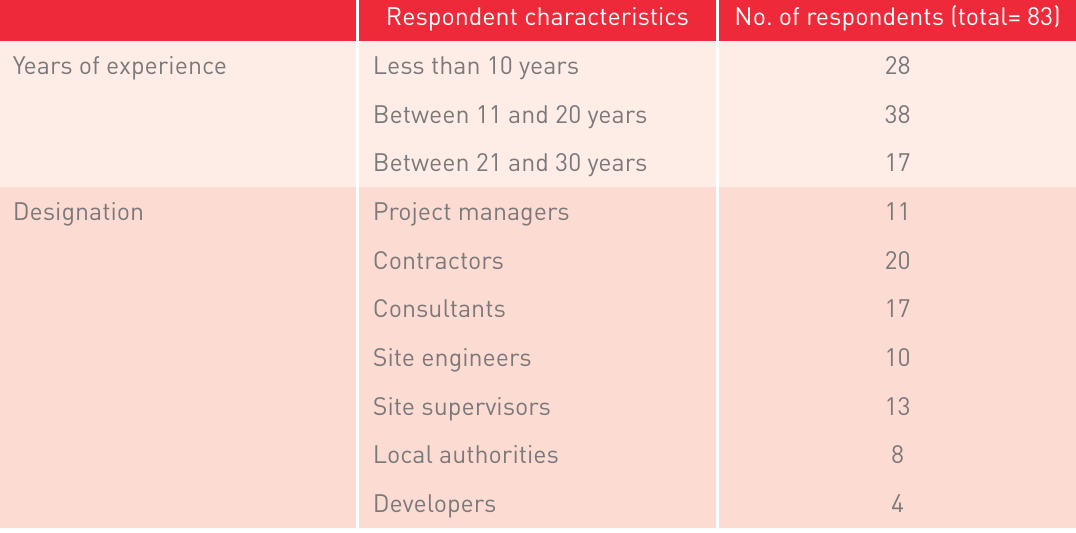
Table 1. Demographic profile of respondents Respondent characteristics No. of respondents (total= 83) Years of experience Less than 10 years 28 Between 11 and 20